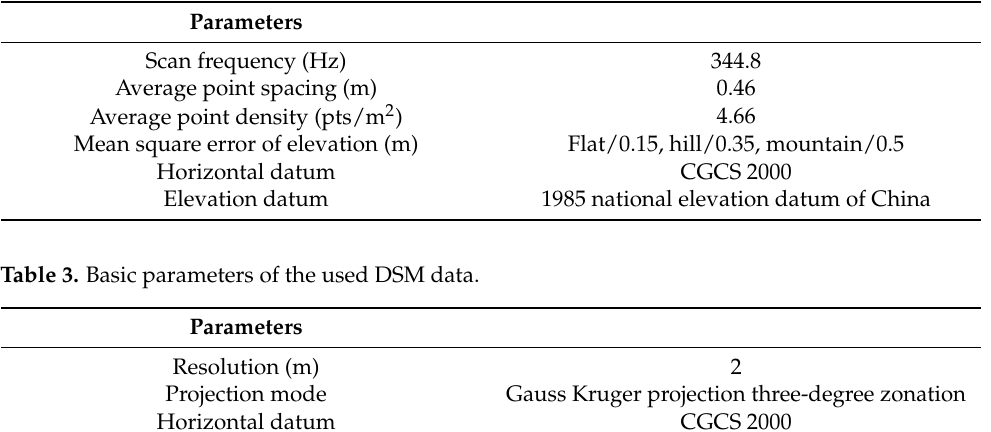
Table 2. Basic parameters of the used LiDAR data.